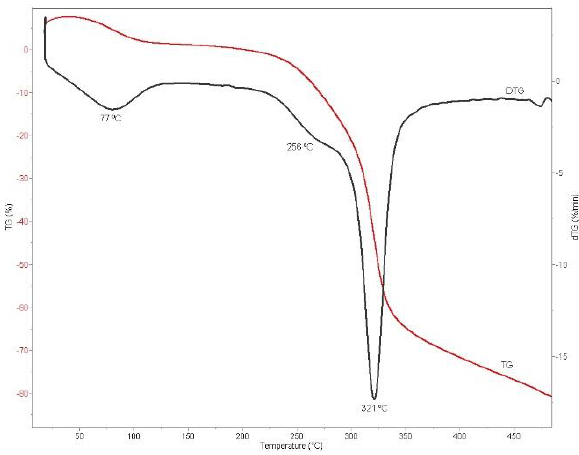
Figure 4. Differential thermal analysis (DTG) curve obtained for the CRS sample.